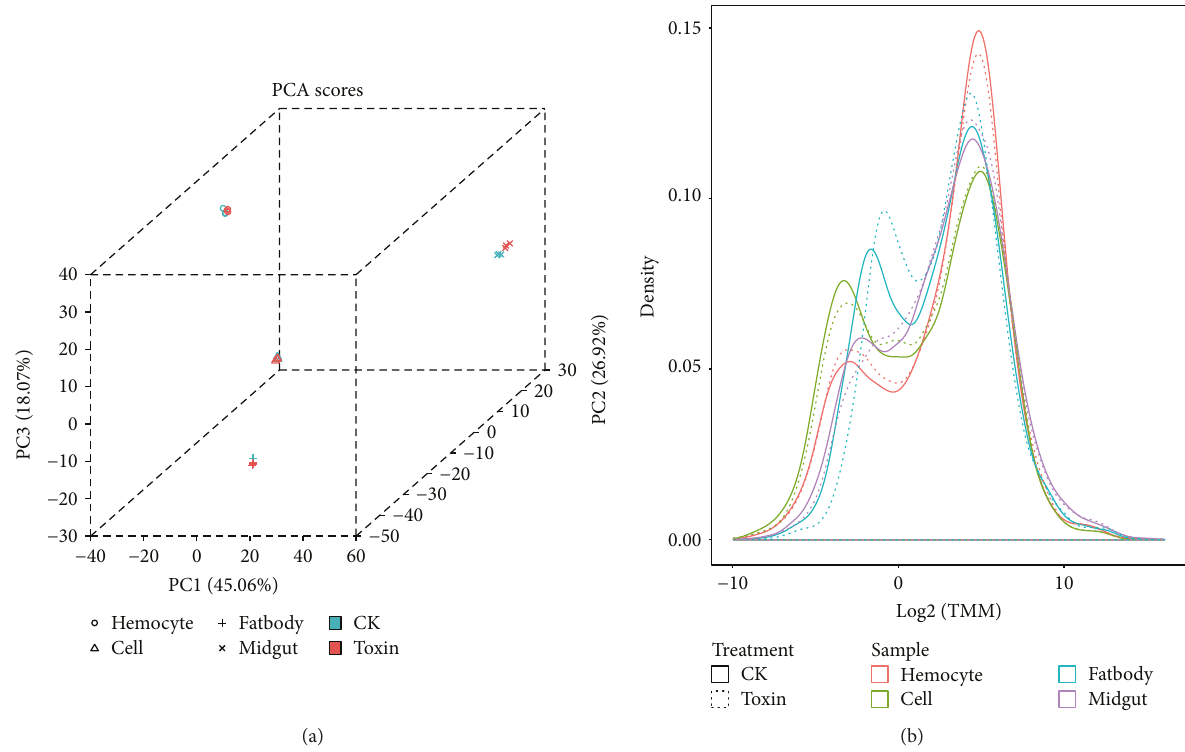
Figure 1: Gene expression pro fi le in response to α -toxin challenge. The expression levels are measured as trimmed mean of M values transformed by log2. (a) The three-dimensional scatterplot of PCA scores. (b) Kernel density plot of the expression pro fi les of genes identi fi ed as